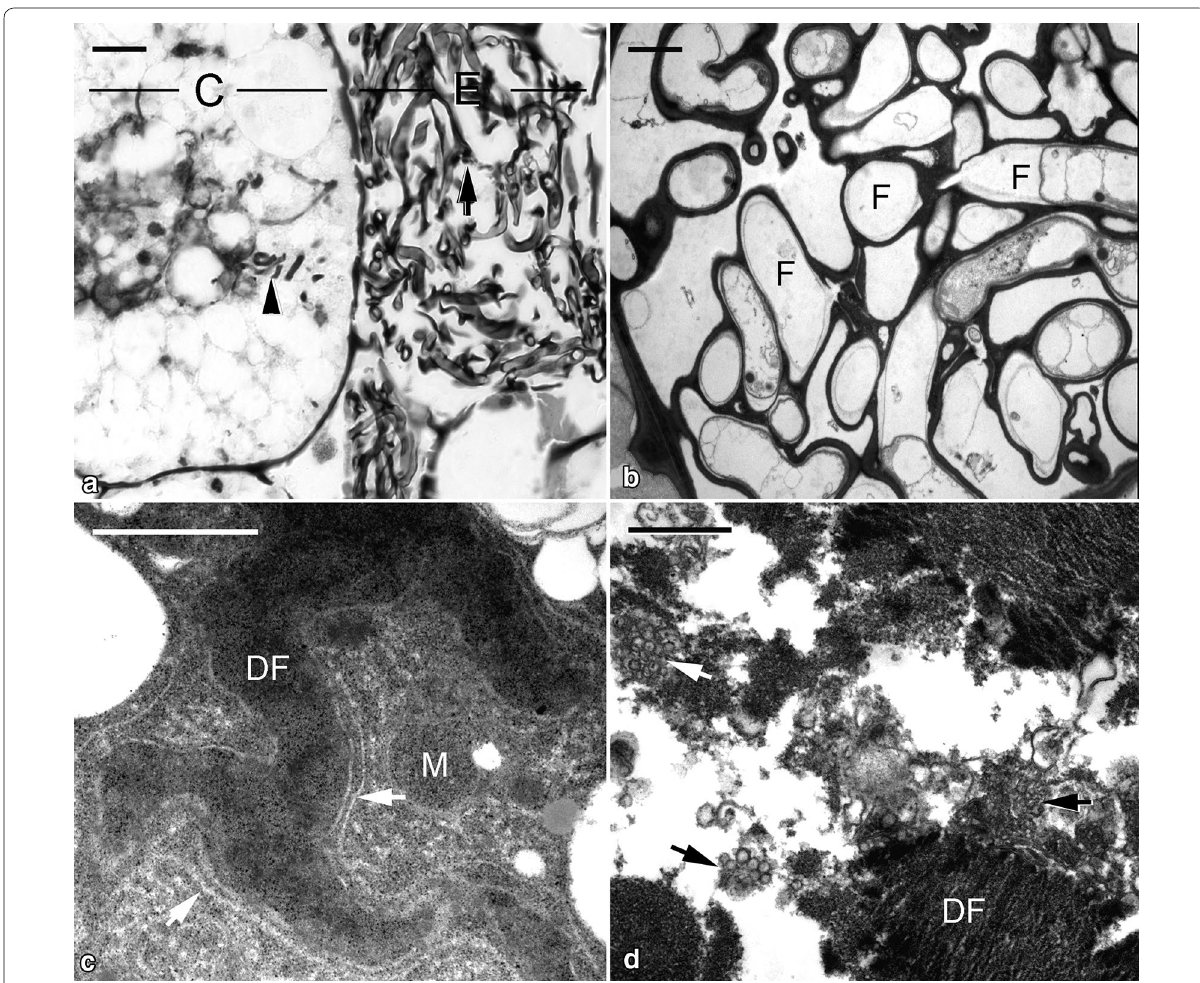
Fig. 4 Micrographs showing the elongated protocorm of G. elata associated with Mycena . a Light micrograph showing the colonized region of the elongated protocorm. The epidermal cell (E) contains old fungal hyphae (arrow), and fragments of digested fungal hyphae (arrowhead) are visible in the cortical cell (C). Scale bar 10 μm. b In the epidermal cell of the elongated protocorm, the cytoplasm of old fungal hyphae (F) has degenerated. = Scale bar 2 μm. c In the cortical cell of the elongated protocorm, the digested fungal hyphae (DF) are surrounded by rough endoplasmic = reticulum (arrows) and a few mitochondria (M). Scale bar 1 μm. d The digested fungal hyphae (DF) become fragmented and associated with = clusters of vesicles (arrows). Scale bar 1 =